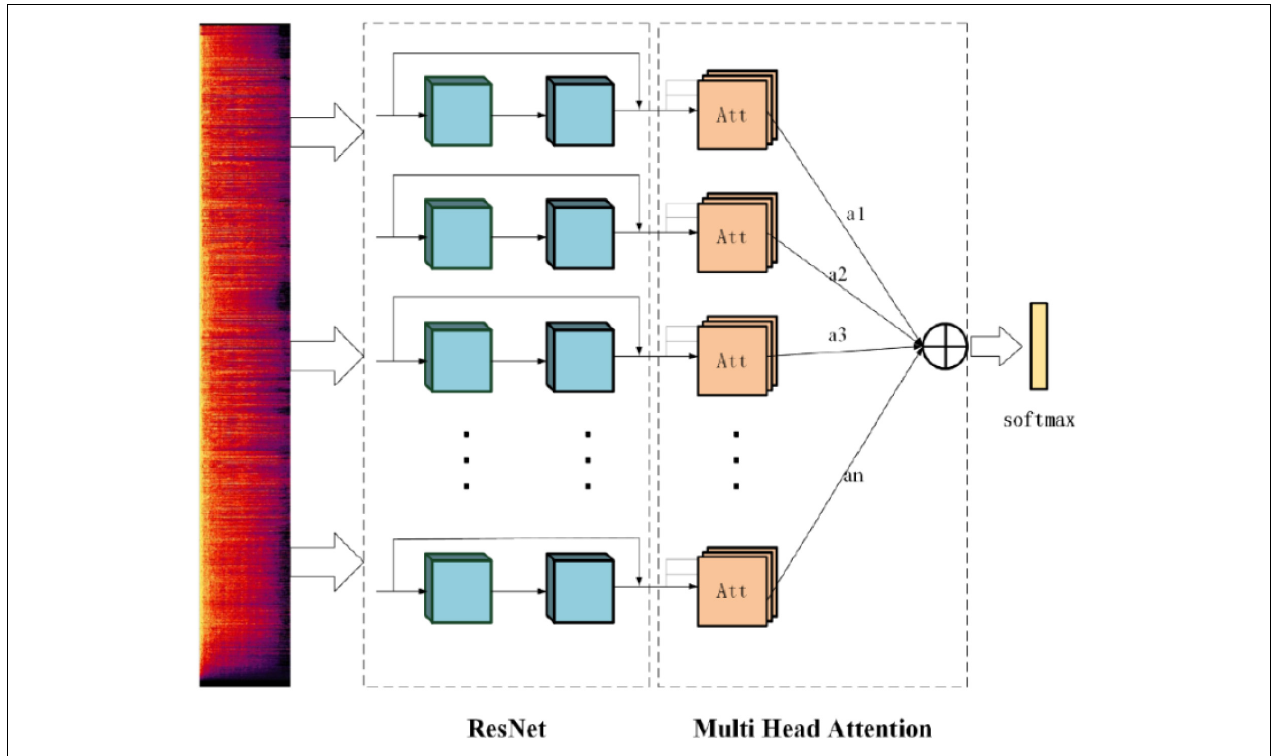
FIGURE 7 | Multi-head attention residual network